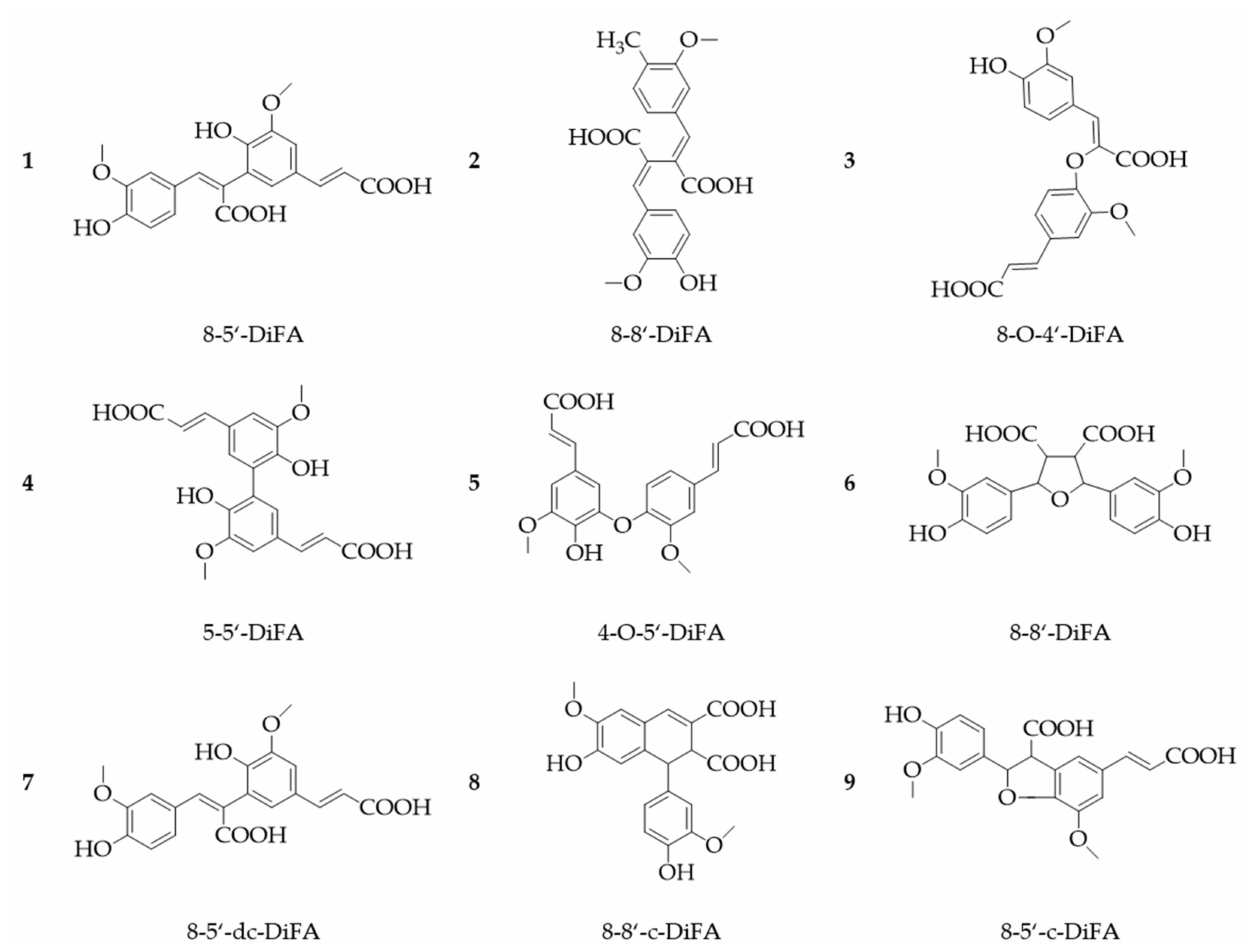
Figure 5. Chemical structures of selected ferulic acid dimers. ( 1 ): 8-5 (cid:48) -dehydrodiferulic acid (DiFA); ( 2 ): 8-8 (cid:48) - dehydrodiferulic acids; ( 3 ): 8-O-4 (cid:48) -dehydrodiferulic acid; ( 4 ): 5-5 (cid:48) -dehydrodiferulic acid; ( 5 ): 4-o-5 (cid:48) -dehydrodiferulicacid; ( 6 ): 8-8’-tetrahydrofuran (THF)-diferulic acid; ( 7 ): 8-8 (cid:48) -cyclic(c)-diferulic acid; ( 8 ): 8-5 (cid:48) -decarboxylated (dc)-diferulic acid; ( 9 ): 8-5 (cid:48) -cyclic-diferulic acid